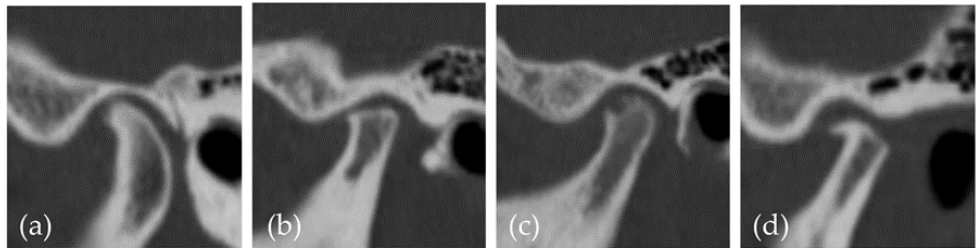
Figure 1. Cone-beam computed tomography (CBCT) findings: ( a ) sclerosis; ( b ) flattening; ( c ) erosion; and ( d ) osteophyte.